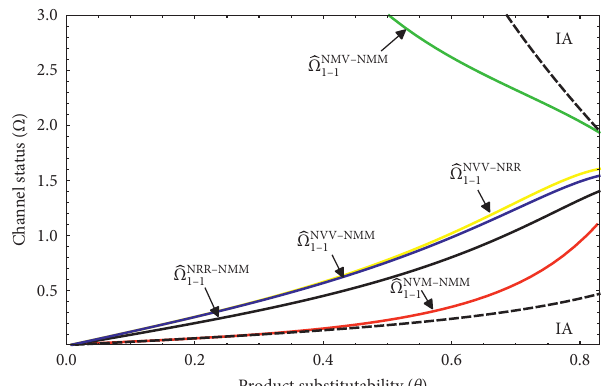
Figure 11: Comparison with respect to channel 1 efficiency among all